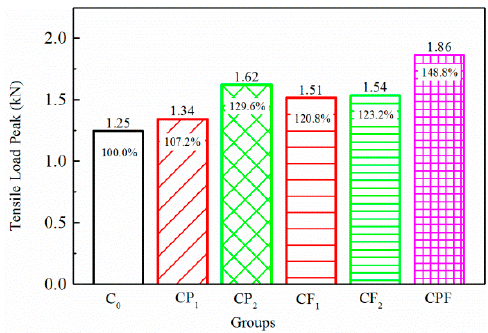
Figure 13. Initial tensile load for 0.1 mm crack opening.